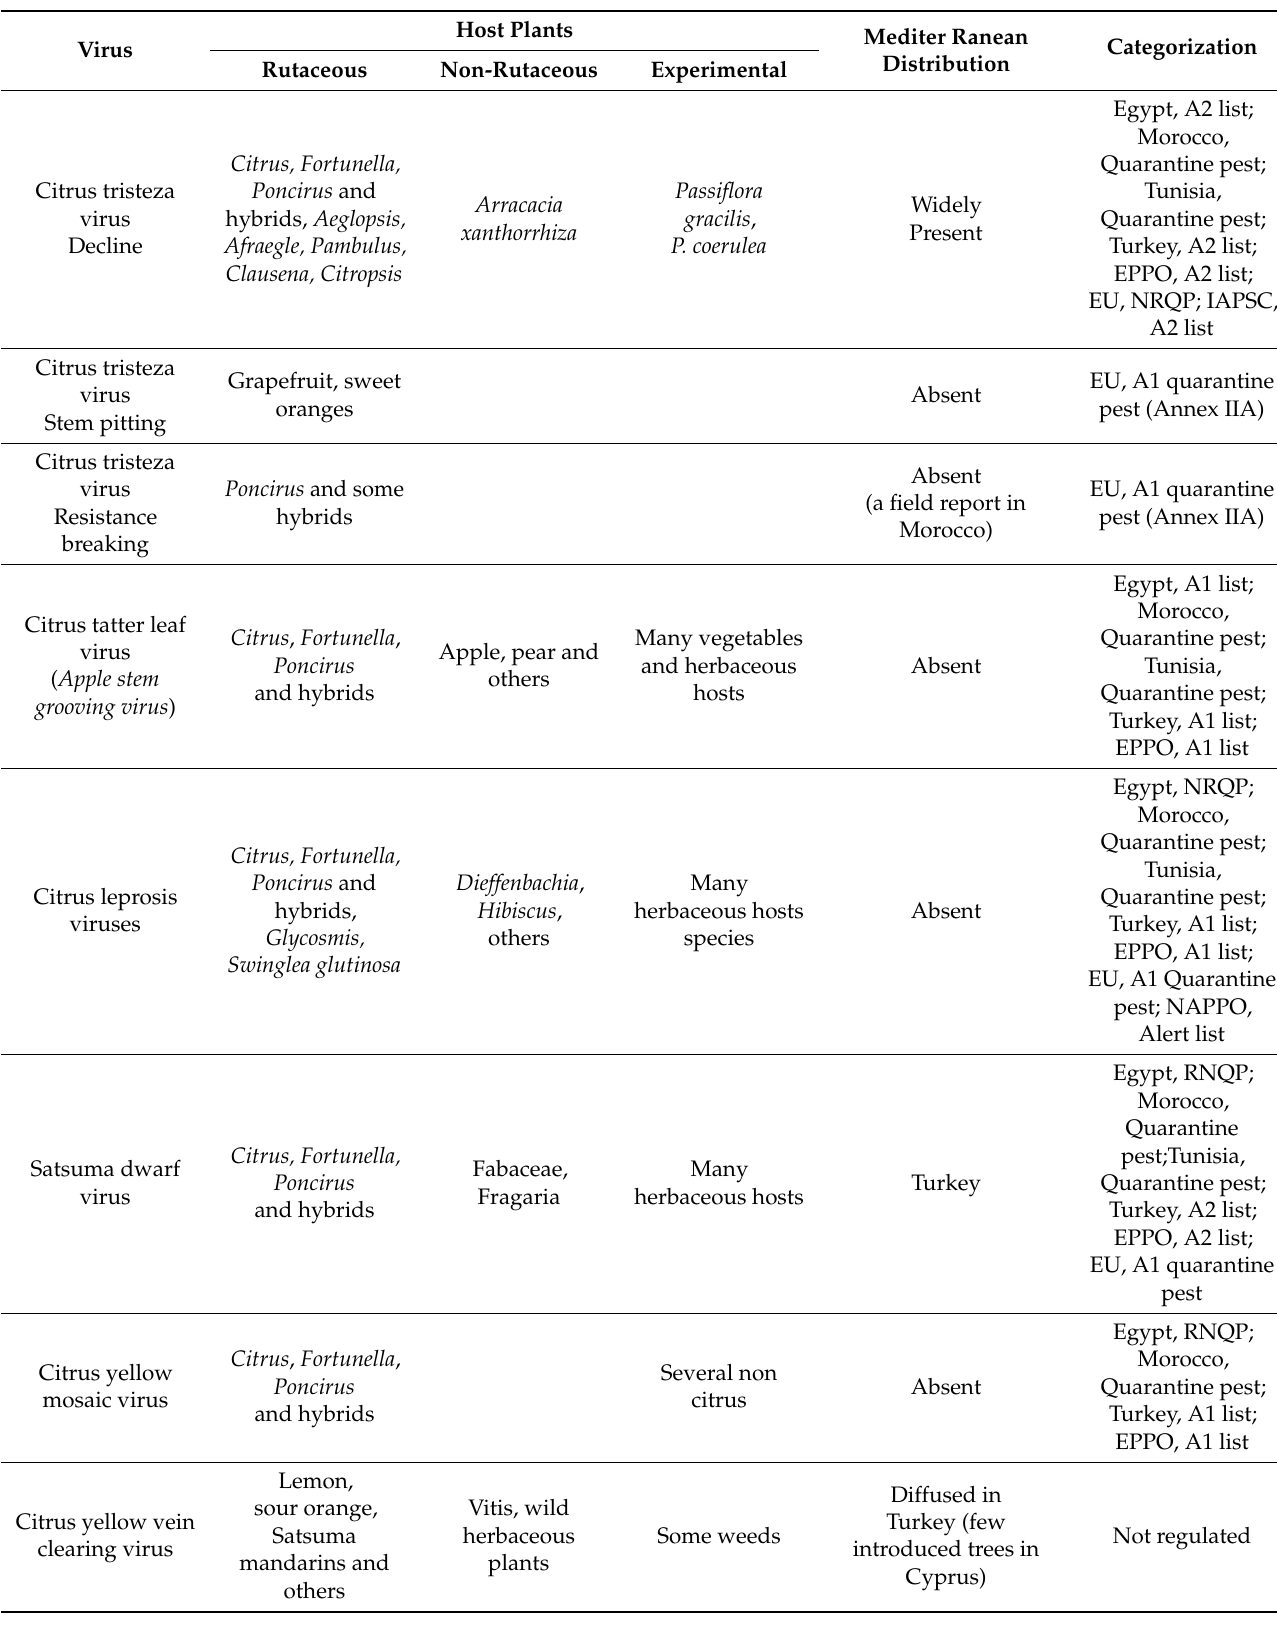
Table 1. List of exotic and emergent viruses relevant to the Mediterranean region as per the EPPO Global Database (accessed in July 2021) (and bibliographic database (in